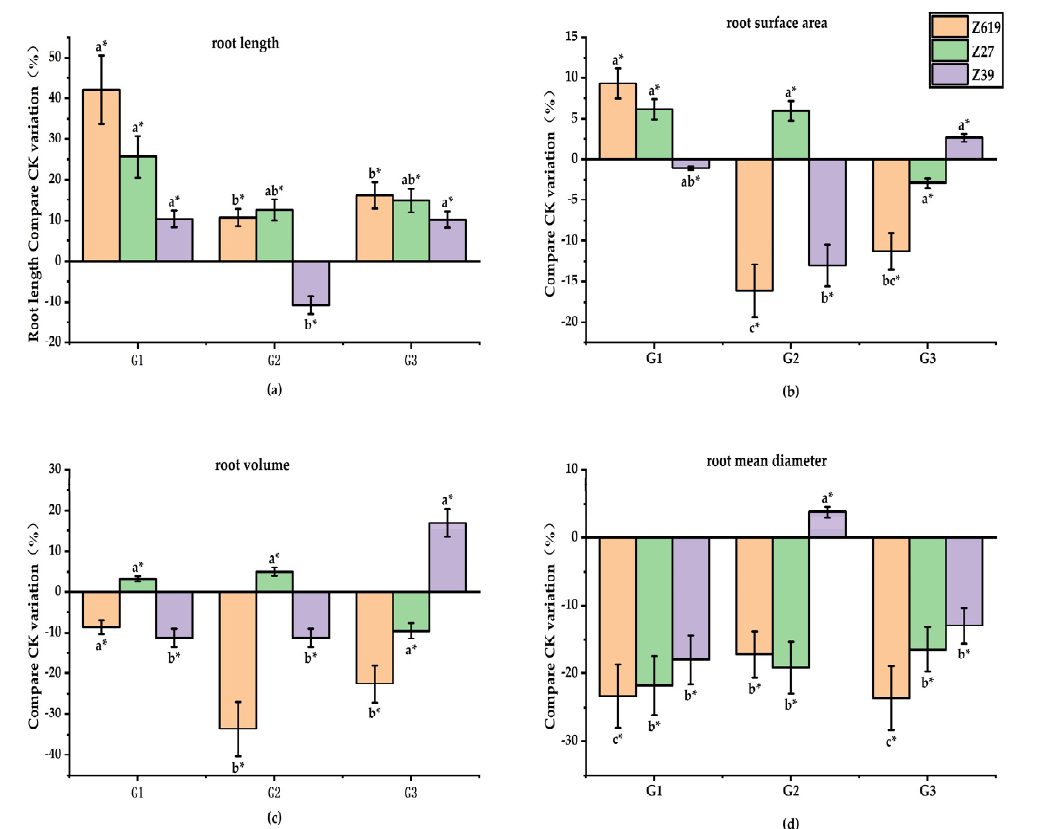
Figure 1. ( a ) Effects of different concentrations of gibberellin on root length; ( b ) Effects of different concentrations of gibberellin on root surface area; ( c ) Effects of different concentrations of gibberellin on root volume; ( d ) Effect of different concentrations of gibberellin on root mean diameter. * Different lowercase letters in the figure indicate that different treatments of the same variety have significant differences at p < 0.05.